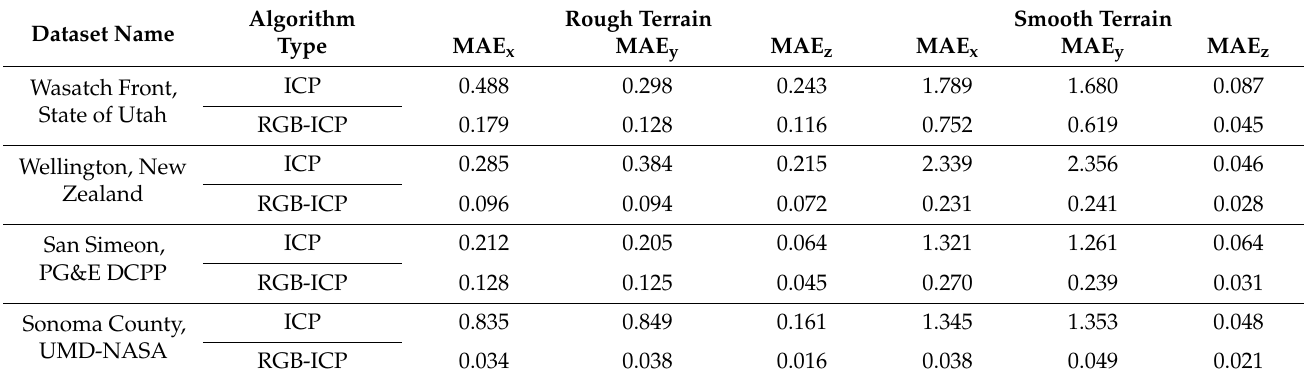
Table 2. Accuracy evaluation table of the two algorithms (unit: